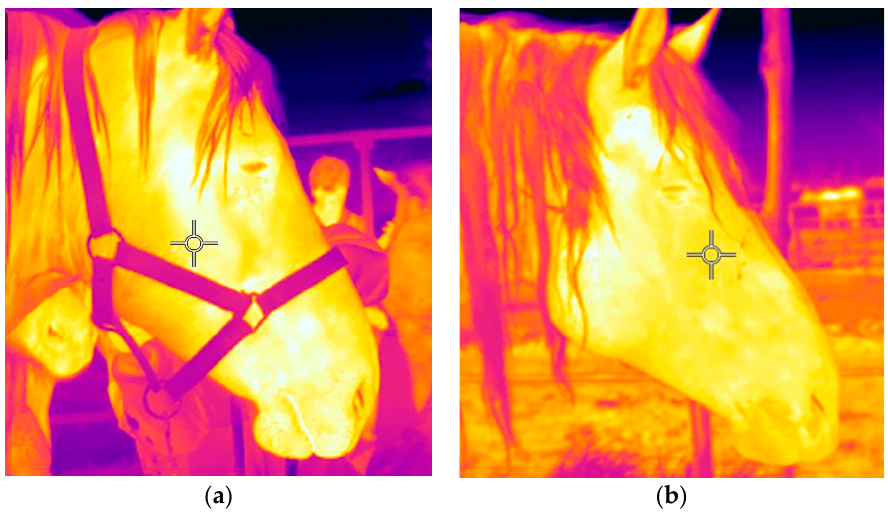
Figure 2. Infrared thermography images collected at the end of Broken/Unbroken Test (BUT) in haltered ( a ) and non-haltered horses ( b ).